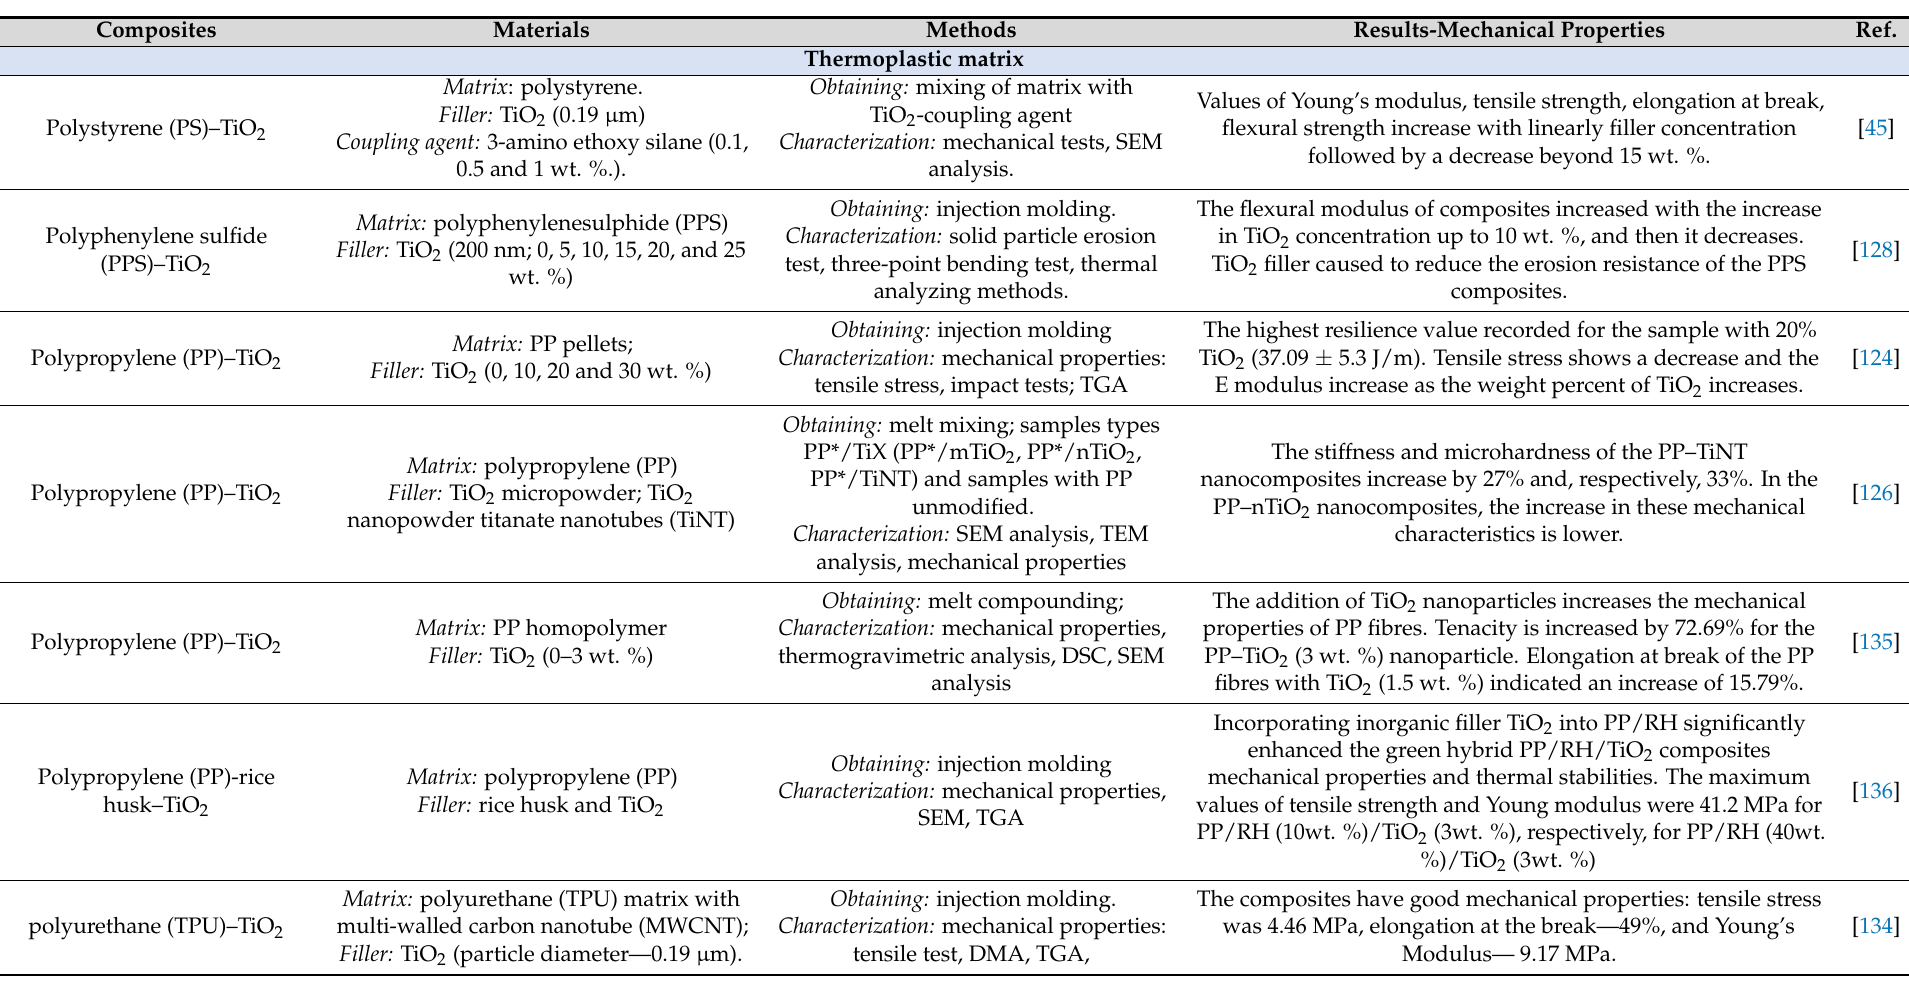
Table 3. Types of nanocomposites with polymeric matrix and TiO 2